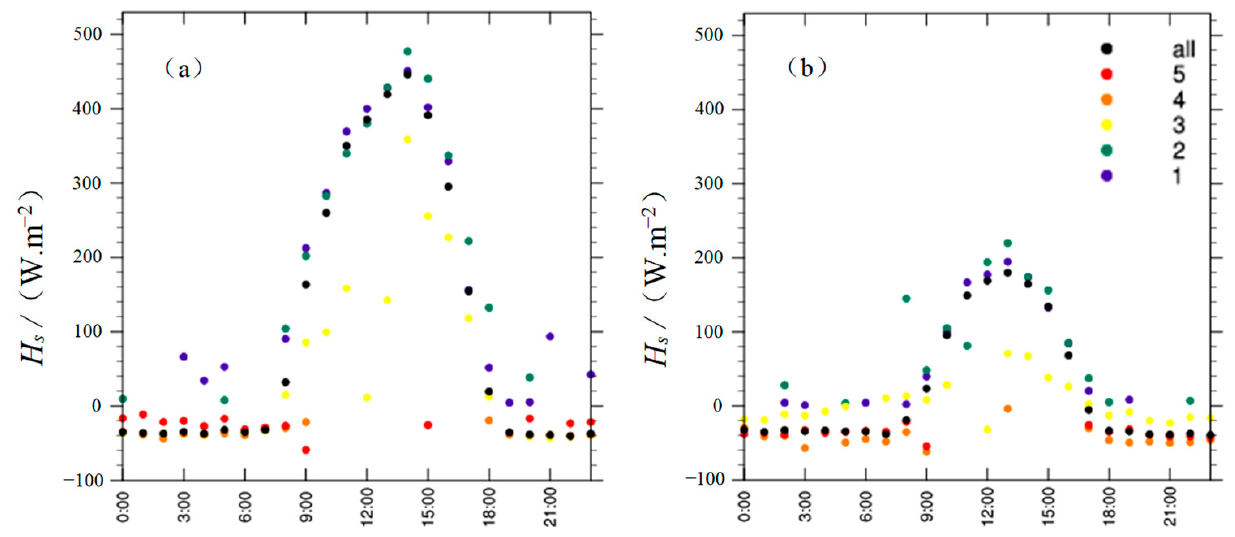
Figure 7. The diurnal variation of the sensible heat flux in different atmospheric stabilities at ( a ) site 1 and ( b ) site 2. Stability level 1: unstable; 2: weak-unstable; 3: neutral; 4: weak-stable; and 5: stable.